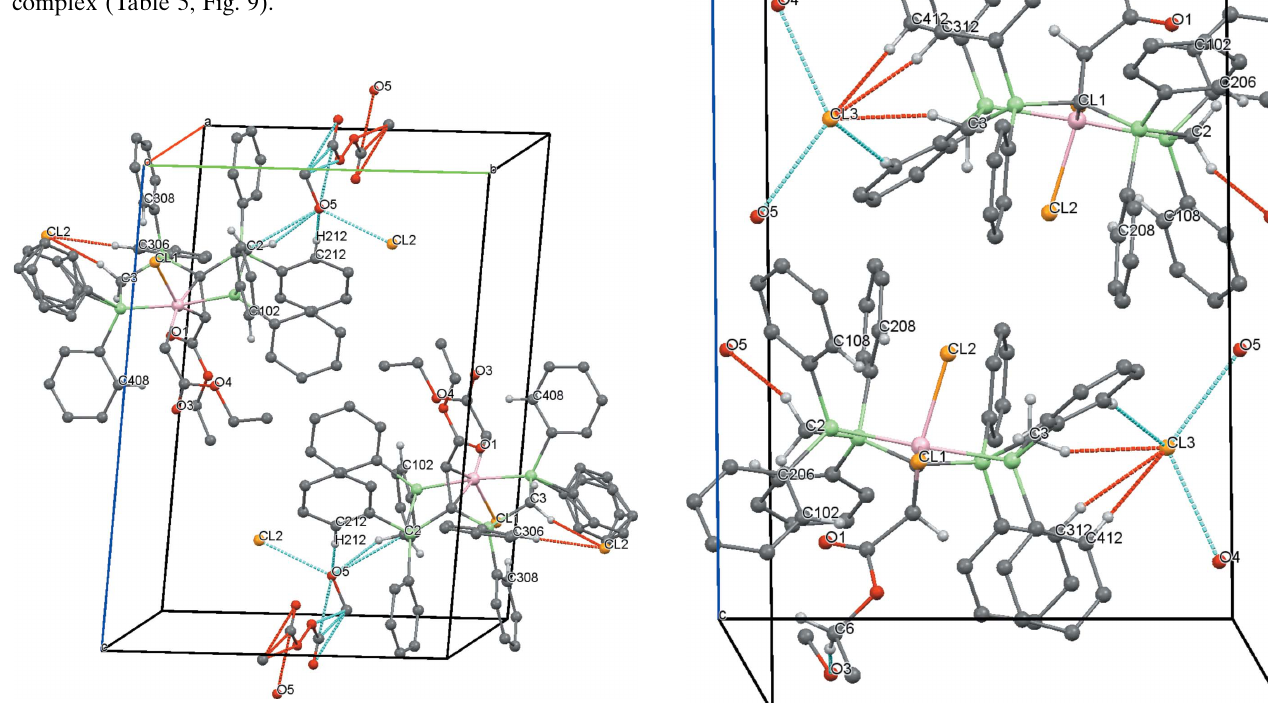
Figure 8 Aview along the a axis of the crystal packing of compound 6 . Only the H atoms involved in the most significant intermolecular interactions (Table 4) are presented and the intramolecular interactions are